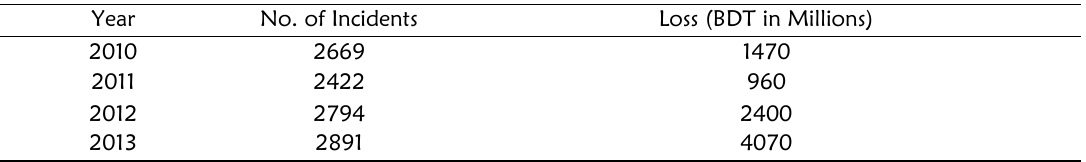
Table 1: Economic loss due to fire incidents in the greater Dhaka districts